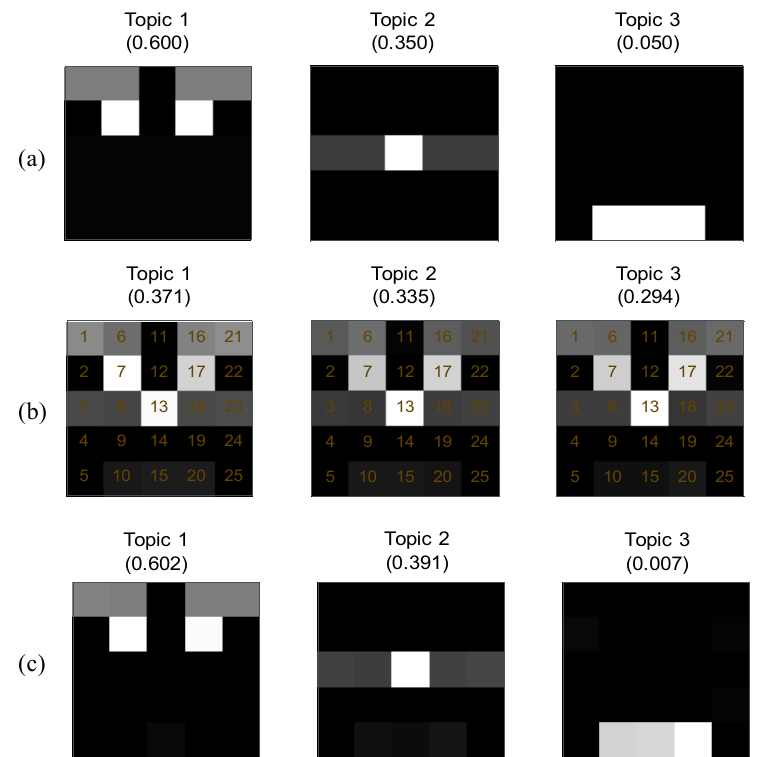
Figure 7. Information generated by the analyses including the: ( a ) ground truth used to generate low-level data; ( b ) LDA model; ( c ) ERT